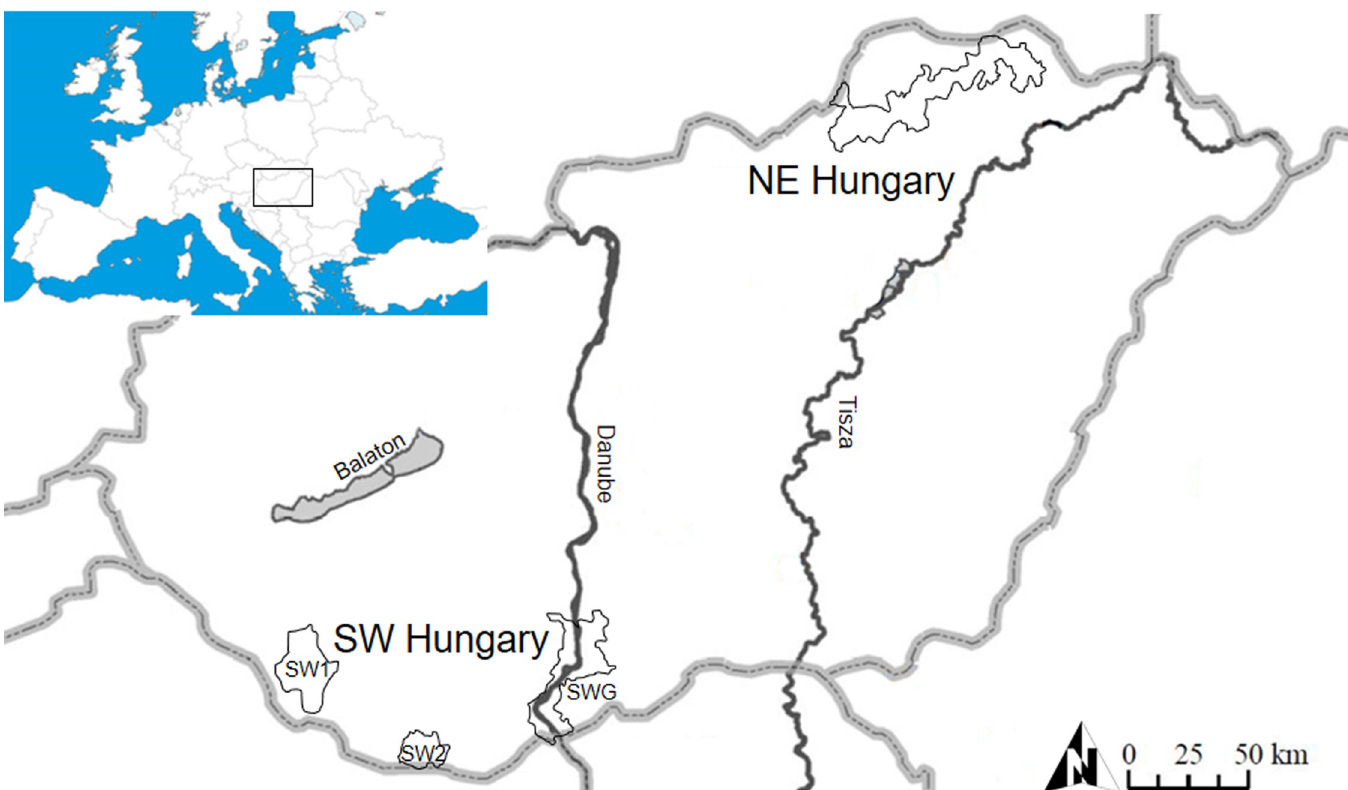
Fig 1. Map of the red deer sampling sites in southwestern (SW) and northeastern (NE) Hungary. Sampling sites: La´bod (SW1, n = 24), Vajszlo´ (SW2, n = 12), Gemenc Forest (SWG, n = 51), and northeastern Hungary (NE, n = 36).